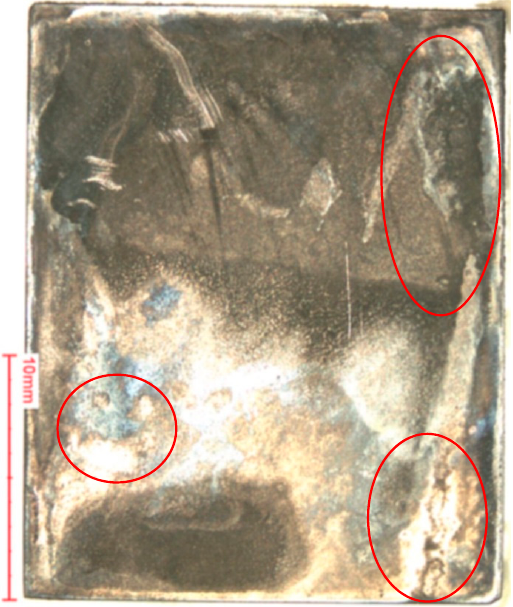
Figure 12. An image for sample B3 exposed to seawater for 28 days (after cleaning). Localized corrosion attacks were found in the steel (red circle). The lower part of the steel sample was affected by corrosion products rolling down.